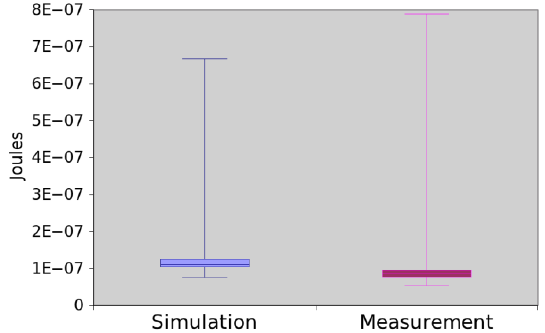
Figure 15. Power consumption of App3